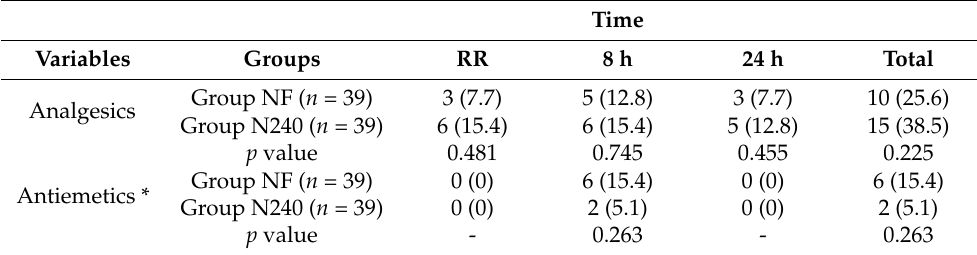
Table 3. Number of patients receiving rescue analgesics and antiemetics.